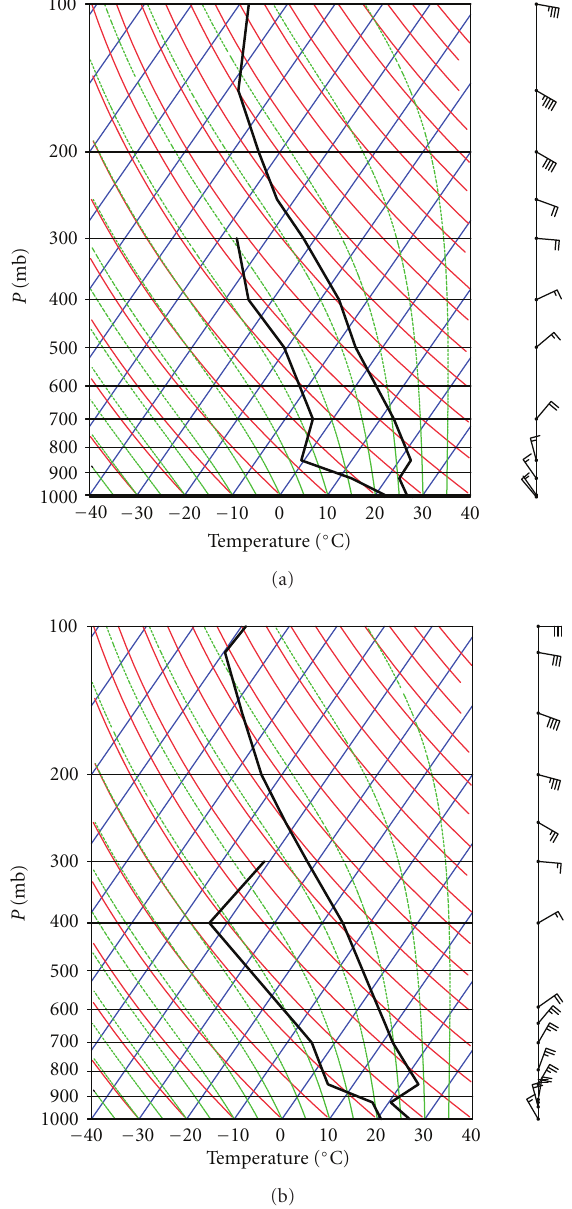
Figure 12: Skew- T plot of rawinsonde data at Dakar on August 11 at 00 Z (a) and 12Z